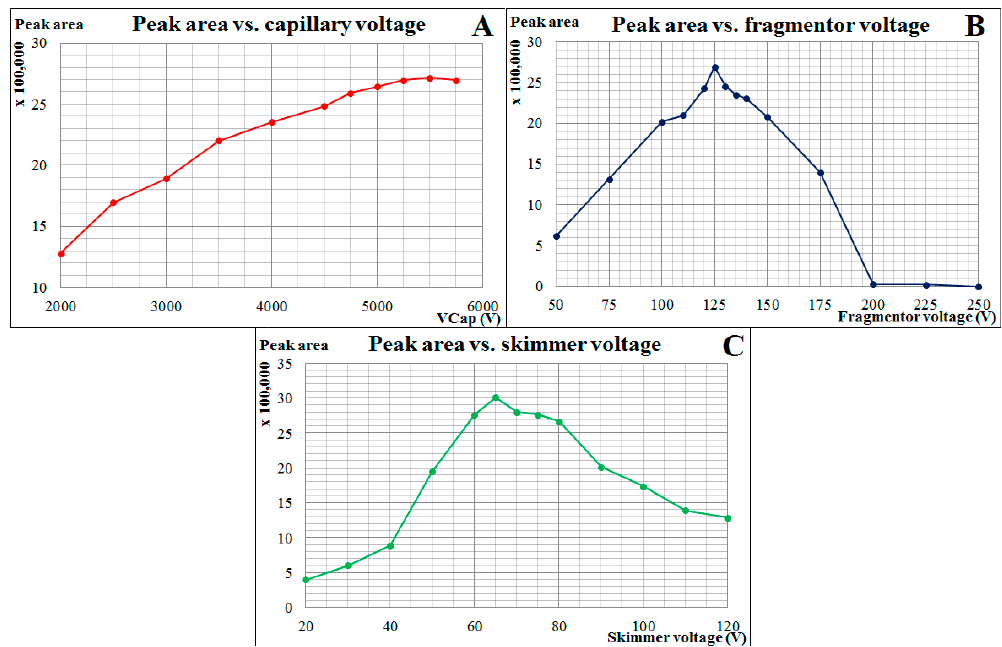
Figure 3. Dependences of Nec-1s detection response on selected MS parameters. FIA experiments were based on direct injection of 1 μ L of Nec-1s stock solution into the Q-TOF apparatus. Diagrams represent following tested parameters: capillary voltage ( A ); fragmentor voltage ( B ); and skimmer voltage ( C ). Peak areas of Nec-1s were evaluated using its EIC profiles. For other Q-TOF parameters and m / z of the evaluated analyte adducts, see Section